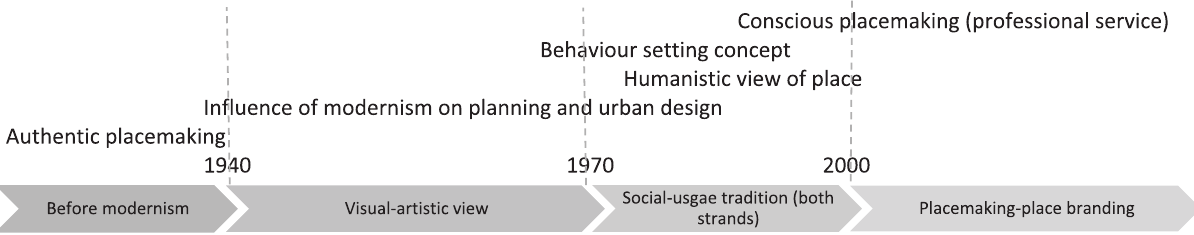
Figure 1. Evolution of urban design thinking. Dates are only approximate as there is overlap between them. Source: authors. Urban Planning, 2019, Volume 4, Issue 2, Pages